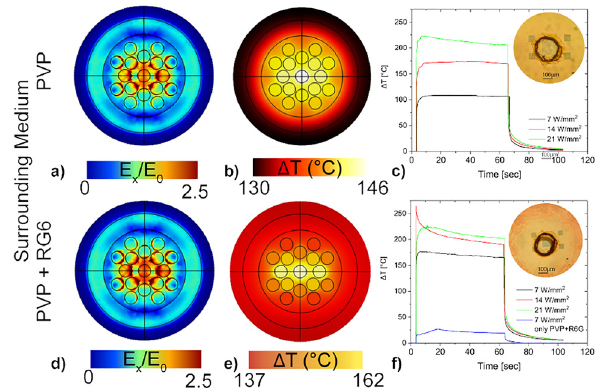
Figure 3: (a) Normalized numerical electric field map and (b) near field thermal map of the proposed geometry embedded into 4 μ m thick PVP layer, (c) experimental macroscopic temperature at different laser ( 𝜆 = 532 nm) intensity for 60 s of irradiation. Inset: optical micrograph of the nanodisks where the black circle represent dissolved/burnt PVP (d) normalized numerical electric field map and (e) near field thermal map of the proposed geometry embedded into 4 μ m thick PVP + R6G dye layer, (f) experimental macroscopic temperature at different laser ( 𝜆 = 532 nm) intensity for 60 s of irradiation. The blue line refers to a measurement where only PVP + R6G are present. Inset: optical micrograph of the nano flower where the black circle represents dissolved/burnt PVP +